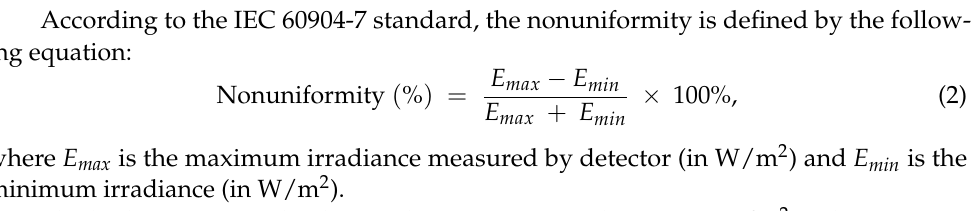
Figure 6. Nonuniformity test (the shadows are due to the photo).